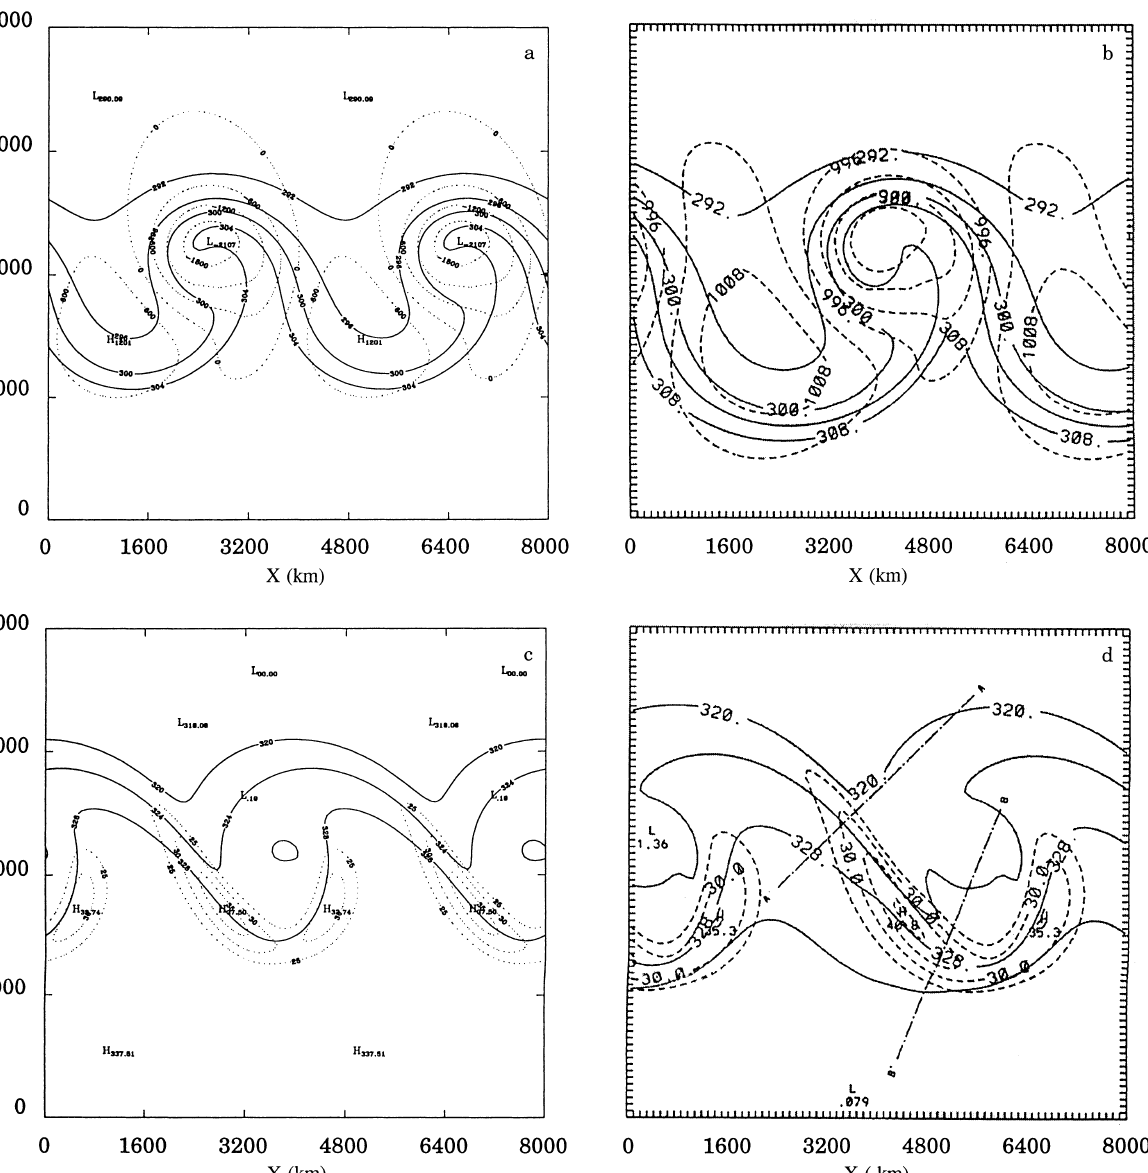
Fig. 14a–d. Results from the baroclinic wave control simulation, compared with those of Lalaurette et al. (1994), using a primitive equation, hydrostatic model, a Surface-level potential temperature (cid:133) solidlines ; 4K (cid:134) and pseudo-geopotential perturbation (cid:85) (cid:133) dashed ; 6hPa (cid:134) computed by Meso-NH at day 8; b surface-level potential temperature (cid:133) solidlines ; 4K (cid:134) and pressure (cid:133) dashed 6hPa (cid:134)